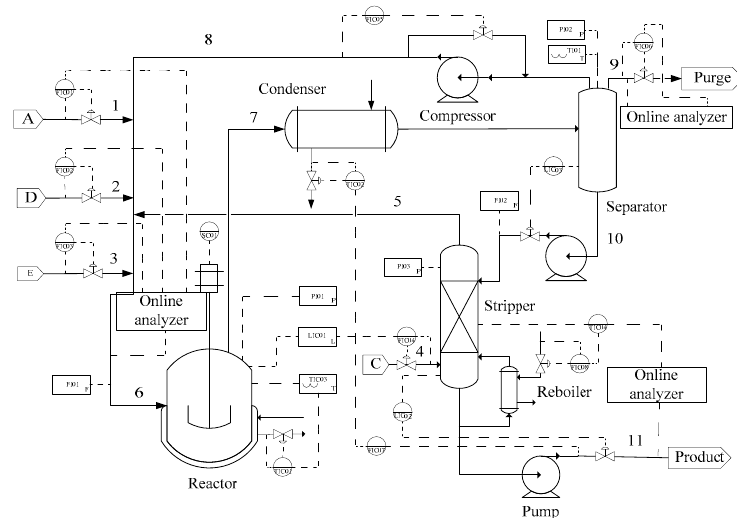
Figure 3. Flow chart of Tennessee Eastman (TE) process. Table 1. TE process heat and mass balance table.